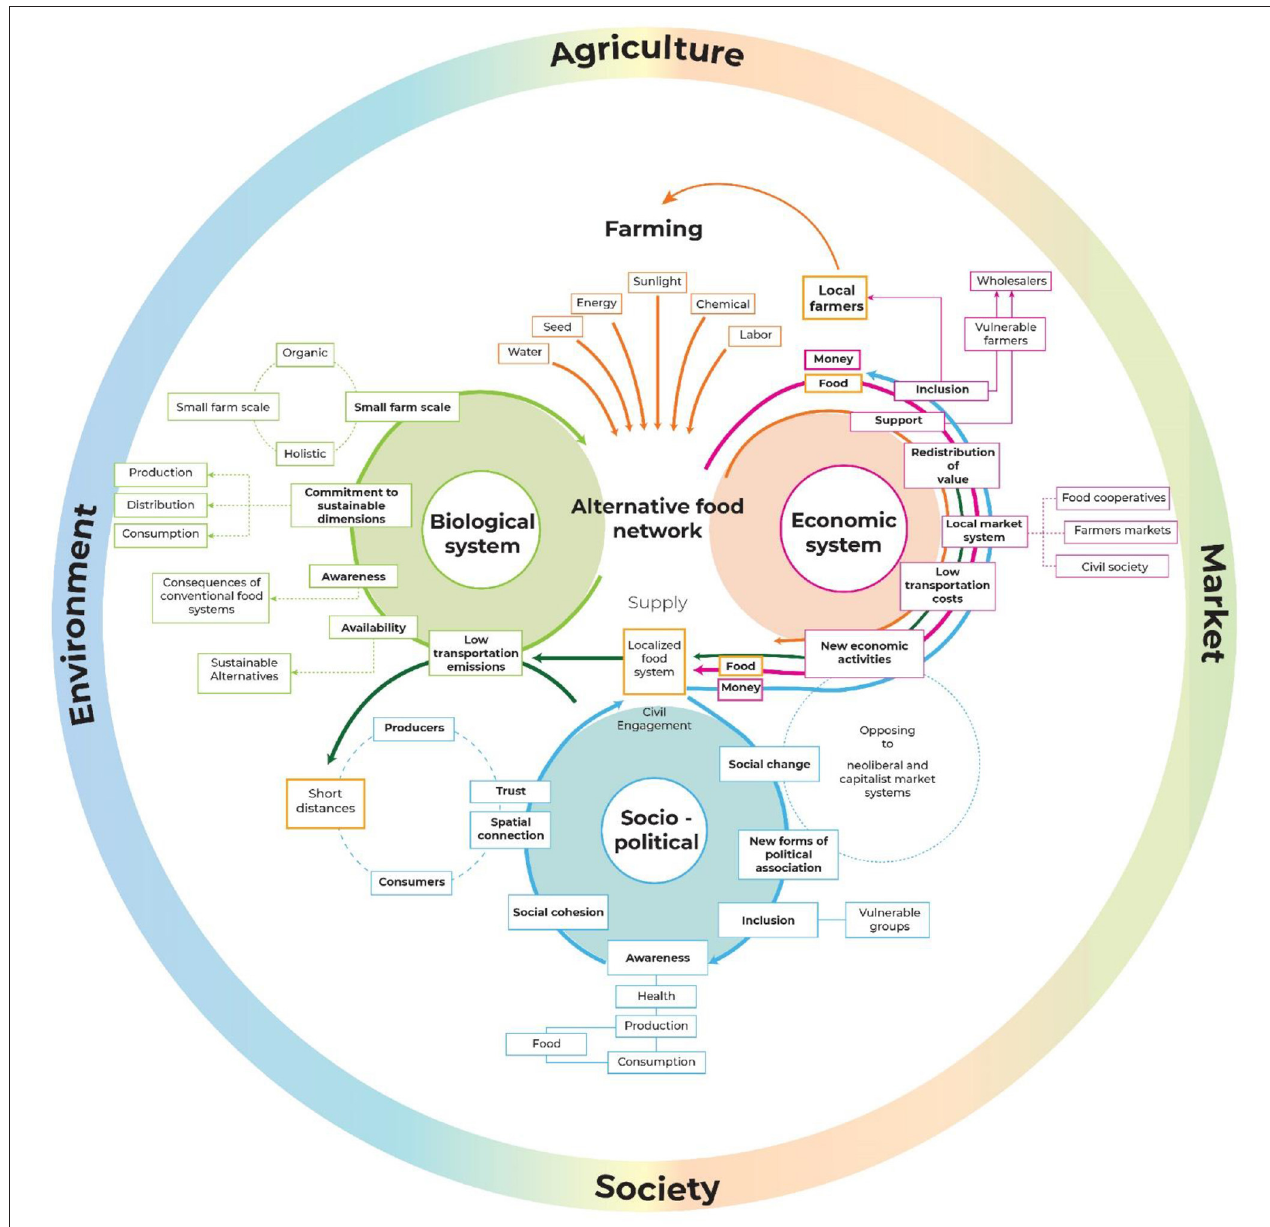
FIGURE 6 | Summary of dimensions and principles followed by AFN as depicted in the Leuven Gymkhana posters. (Source: authors’ adaptation inspired by the “Nourishing Food Systems Map” by The Nourish initiative in Clancy, 2014,